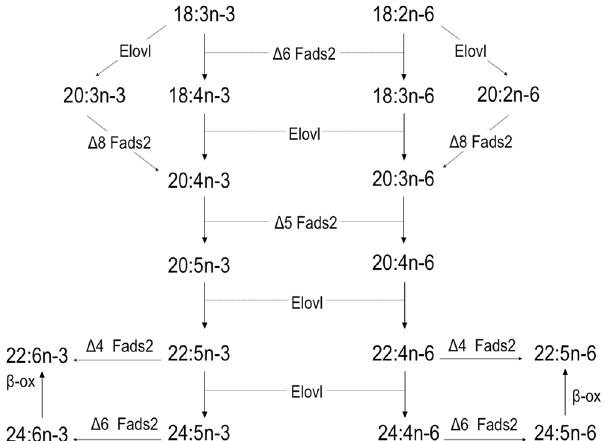
Figure 1. The biosynthetic pathways of long-chain ( ≥ C 20 ) polyunsaturated fatty acids from α -linolenic (18:3n − 3) and linoleic (18:2n − 6) acids accepted for teleosts 6 . Enzymatic activities shown in the diagram are predicted from heterologous expression in yeast ( Saccharomyces cerevisiae ) of fish fatty acyl desaturase 2 (Fads2) and Elongase of very long-chain fatty acid (Elovl) proteins. β -ox, partial β